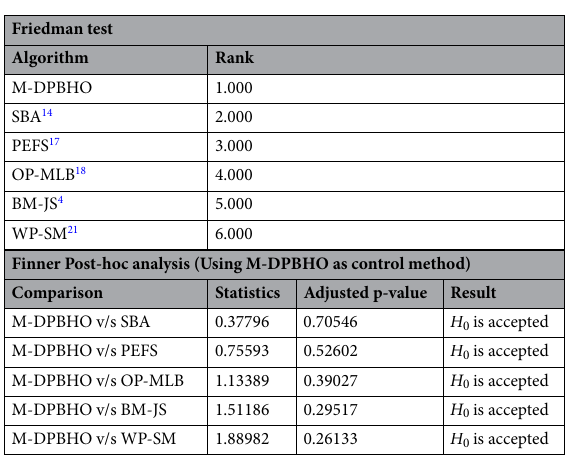
Table 8. Statistical analysis report for M-DPBHO v/s state-of-the-art approaches.